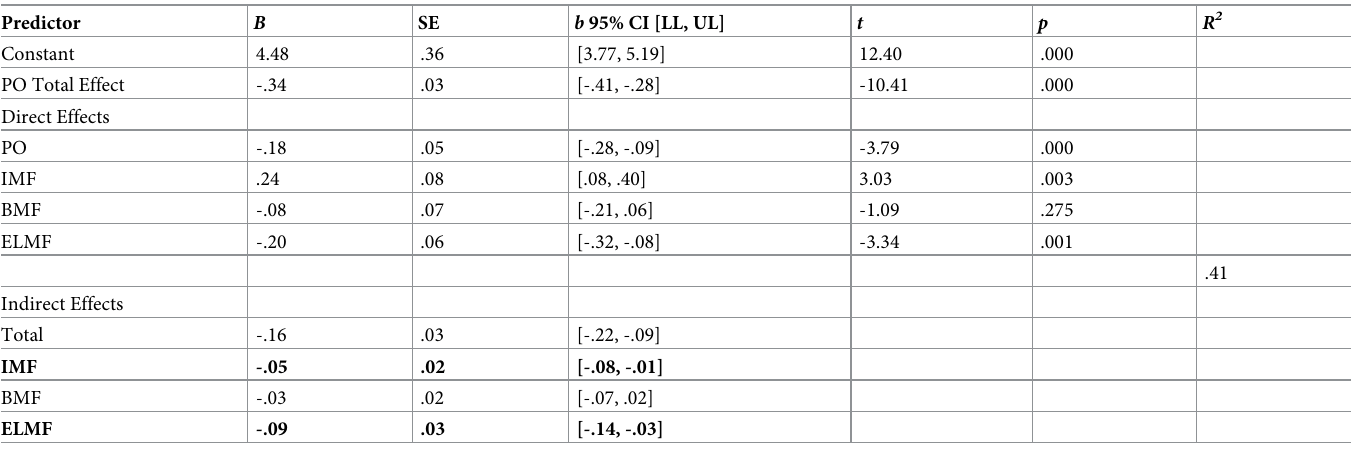
Table 9. Mediation effects of moral foundations on the relationship between political orientation and social distancing attitudes scale–past (N = 209). Predictor B